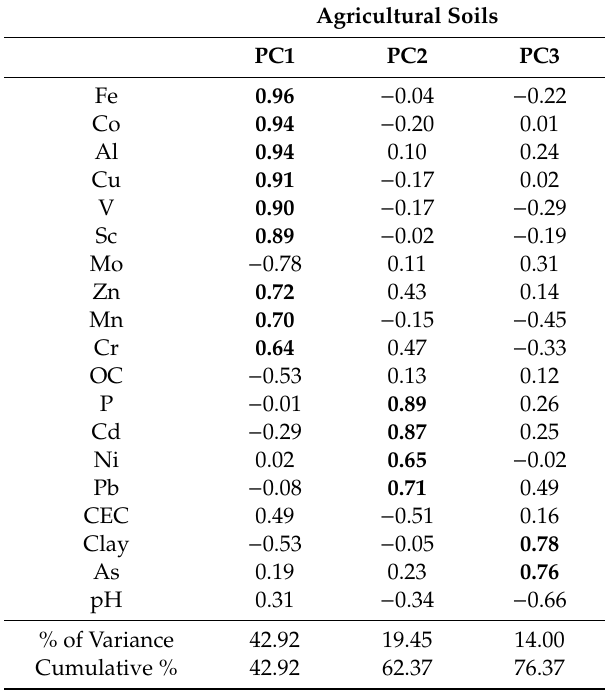
Table 5. Principal component analysis for physicochemical properties and PTE in BAC soils. Agricultural Soils